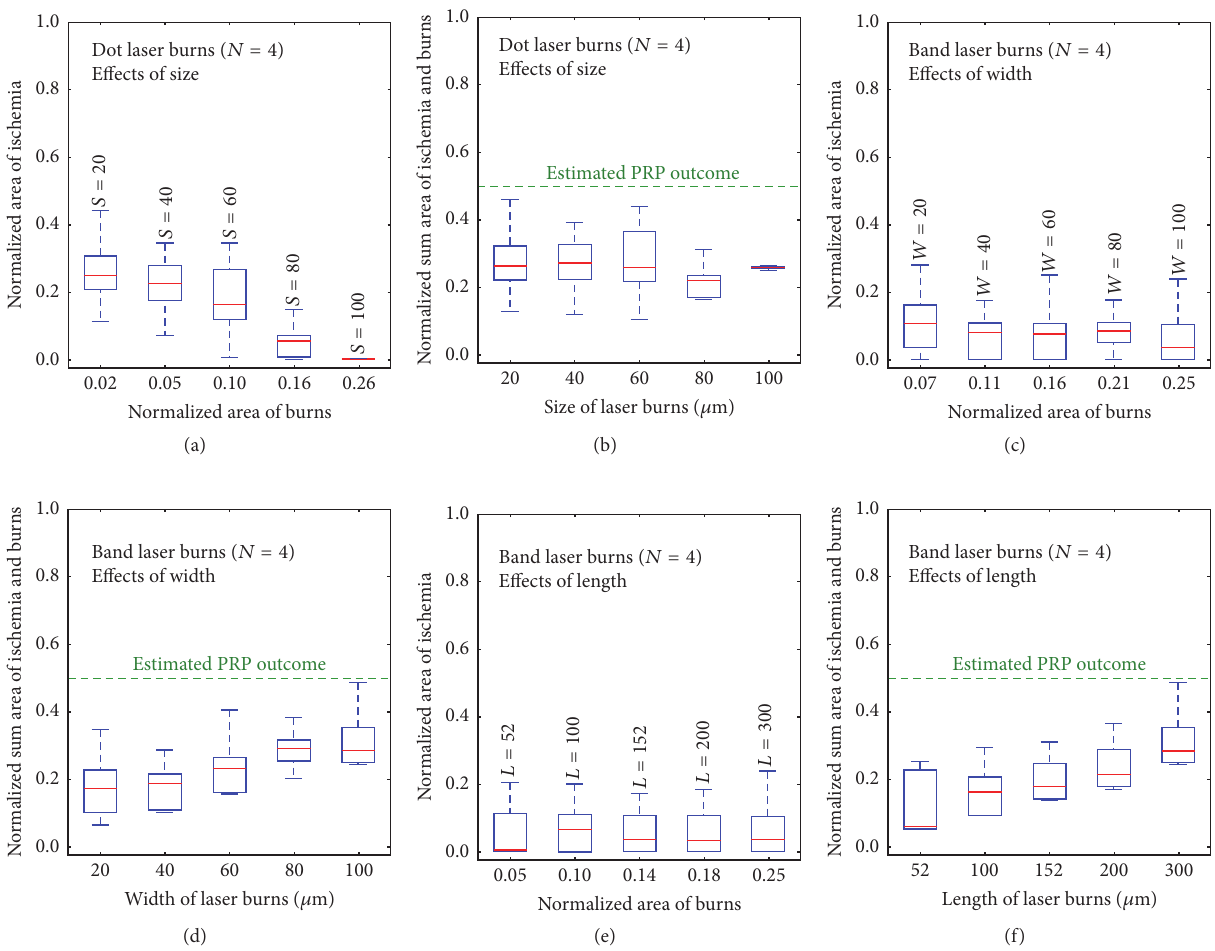
Figure 5: Evaluation of dot pattern size and thinned and shortened band patterns. Replicate simulations with results as box and whisker plots for dot and band pattern burns of different dimensions. Estimated outcome from commonly used panretinal photocoagulation with 1500 burns and 500 micron spots was marked with a green line in panels (b), (d), and (f). (a) Normalized area of dot burns plotted on the 𝑥 -axis and the replicate results plotted on the 𝑦 -axis. (b) Side lengths are given on the 𝑥 -axis and the sum of the ischemic area and burn area is given on the 𝑦 -axis. (c) Replicate outcomes for thinned band pattern photocoagulation therapies at a constant length of 300 microns with normalized band areas corresponding to the different band widths on the 𝑥 -axis and normalized ischemic area on the 𝑦 -axis. (d) Replicate simulations were executed for band patterns with the widths given on the 𝑥 -axis and the sum of the ischemic area and burn area given on the 𝑦 -axis. (e) Replicate outcomes for shortened band patterns at fixed band width of 60 microns with normalized band areas corresponding to the different band lengths on the 𝑥 -axis and normalized ischemic area on the 𝑦 -axis. (f) Replicate simulations for band patterns with the lengths given on the 𝑥 -axis and the sum of the ischemic area and burn area given on the 𝑦 -axis.